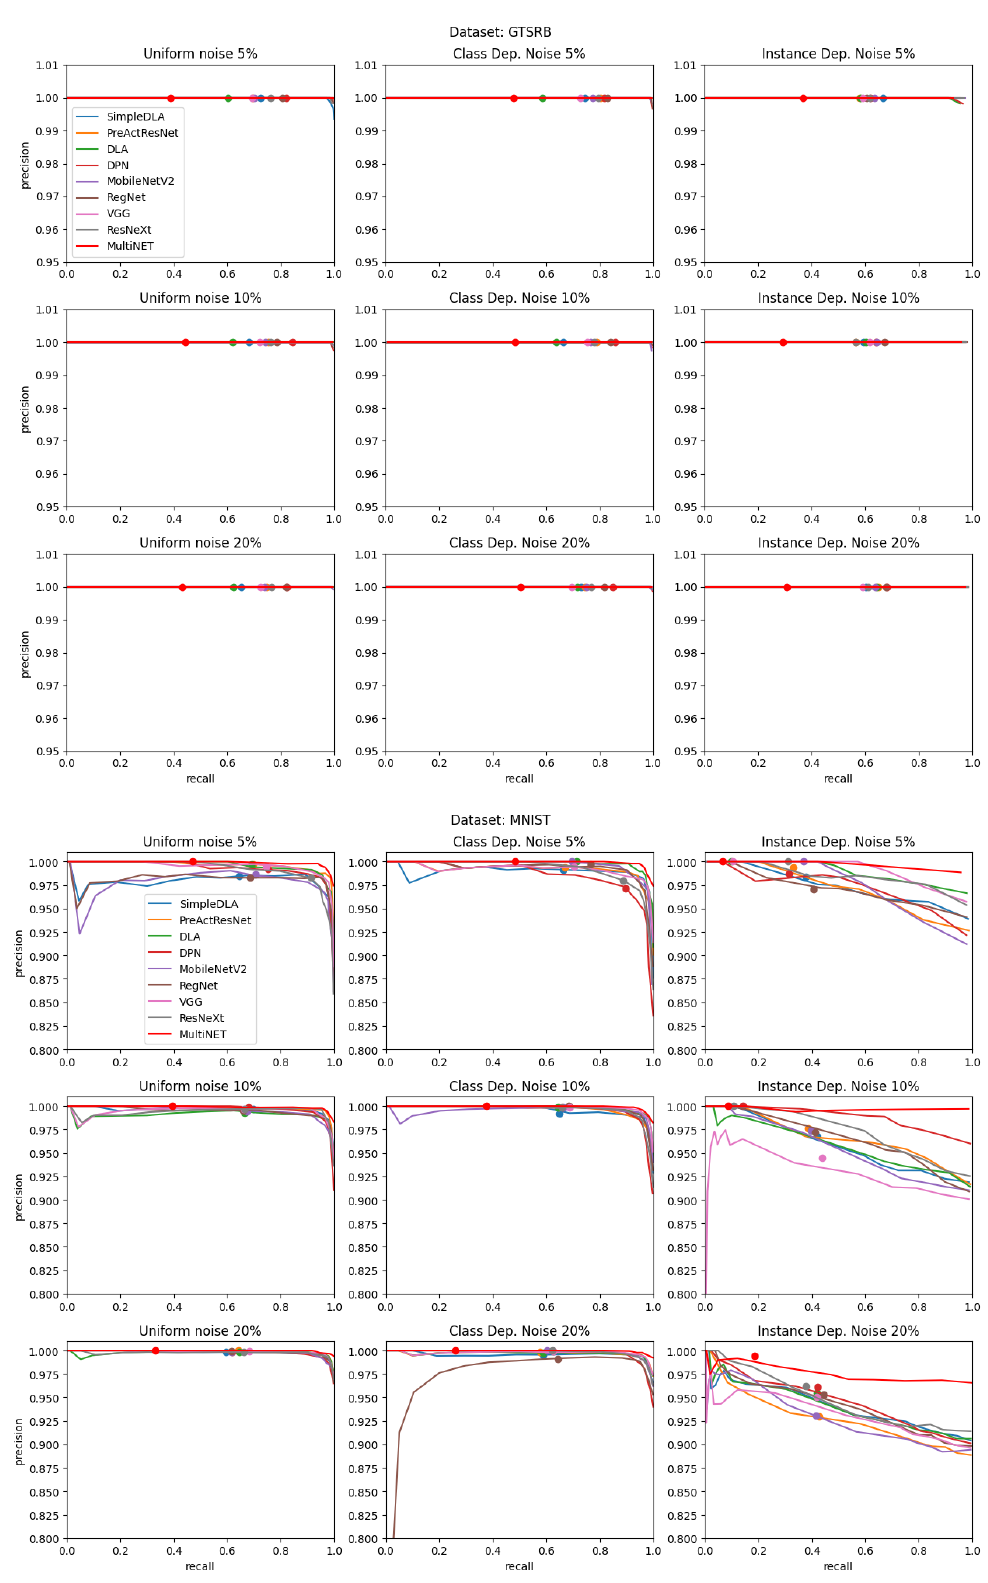
Figure 8. Precision–recall curves for the GTSRB and MNIST datasets. The red line denotes the results of the MultiNET algorithm, while the other curves show the outcomes of single-DNN CL methods. The original concept utilizing the mean confidence level is denoted by a dot on each